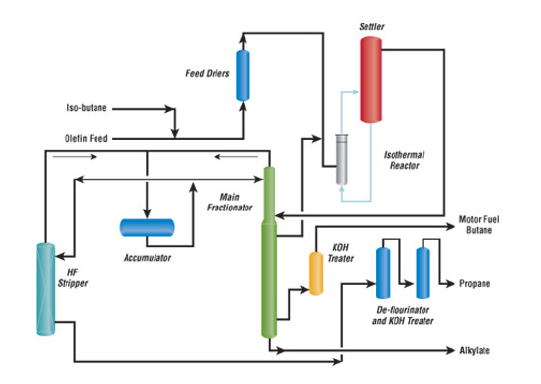
Figure 12. Scheme for HF alkylation process by